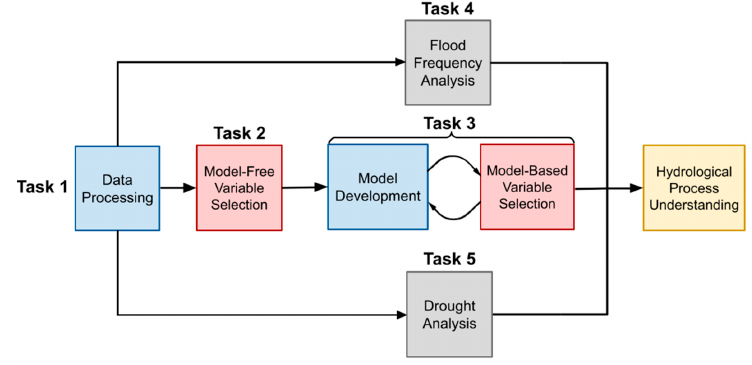
Figure 2. Flowchart depicting the analysis framework for this